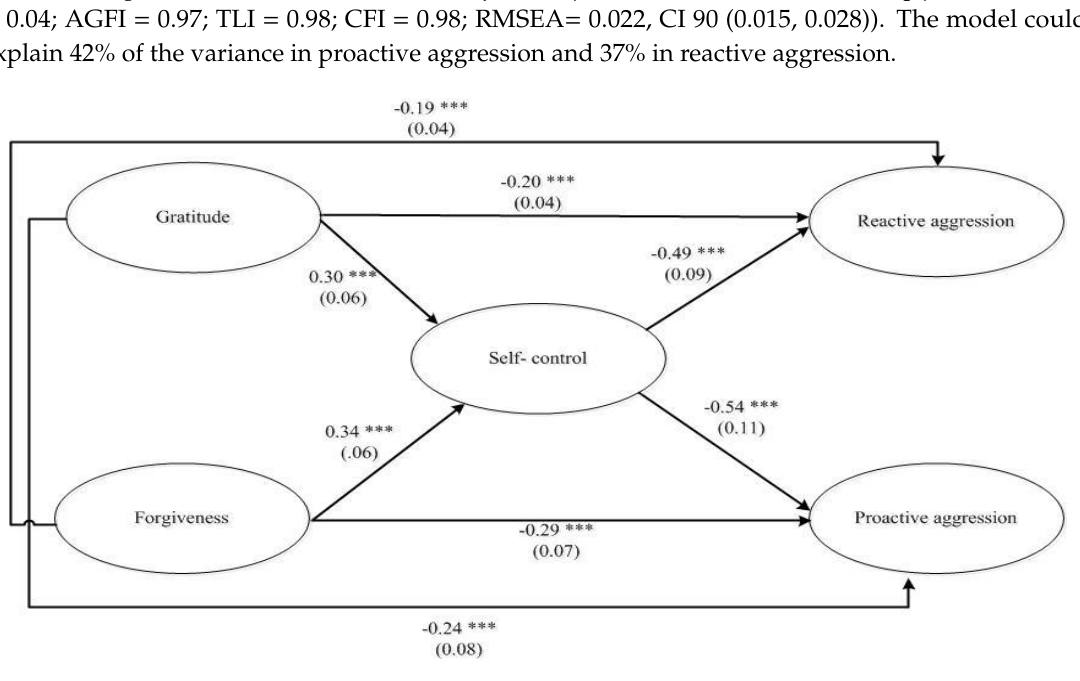
Figure 2. Results of the structural model of the relations between gratitude, self-control, forgiveness, reactive and proactive aggression in adolescents. Note. Standardized coe ffi cients and standard errors are presented. *** p <